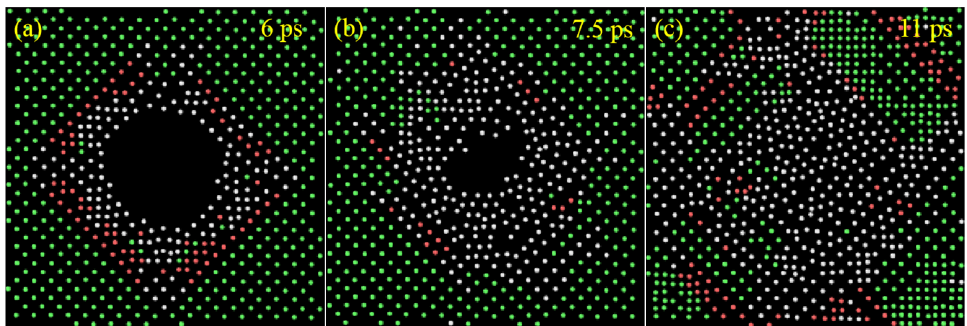
Figure 4. Two-dimensional diagrams of the phase transition of the nanovoid-containing system at 6 ps ( a ), 7.5 ps ( b ) and 11 ps ( c ) when the shock wave velocity is 5 km/s, respectively. Among them, the green color represents the copper atoms in the face-centered cubic (FCC) structure, the red color represents copper atoms in the hexagonal-close packed (HCP) structure, and the white color represents copper atoms in a disordered state.